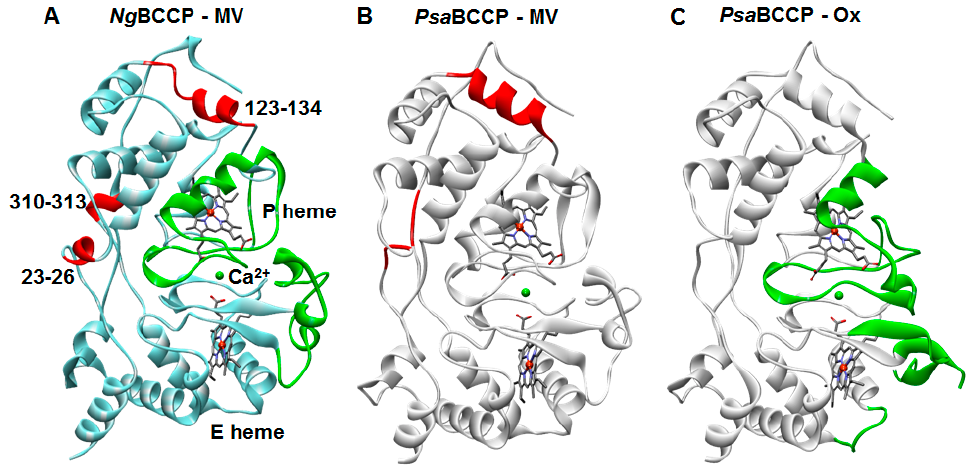
Figure 5. Structure changes that occur upon activation. Structure comparison of ( A ) Ng BCCP mixed-valence (MV) state with ( B ) P. aeruginosa BCCP in the MV ( Psa BCCP–MV) and ( C ) oxidized ( Psa BCCP–Ox) state. In red are highlighted the structural differences between MV states, and in green the differences between oxidation states. Figures prepared with BIOVIA Discovery Studio Visualizer 4.5 using PDB ID 2VHD and 1EB7 for P. aeruginosa BCCP in the mixed-valence and oxidized state, respectively.